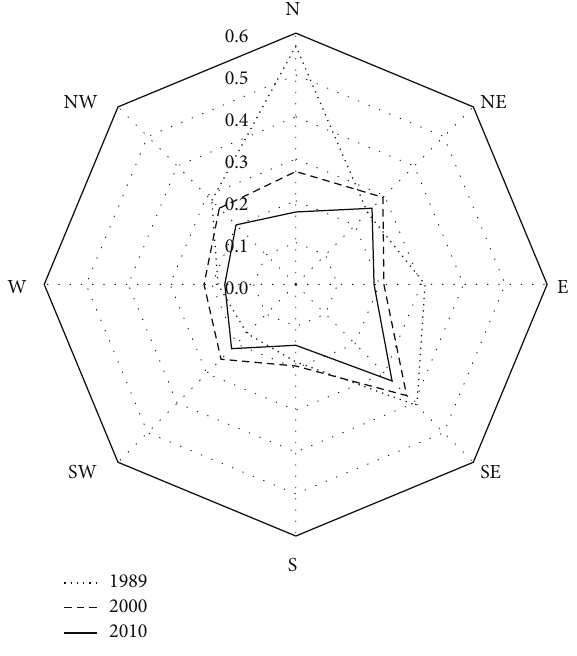
Figure 2: Compactness ratio index.